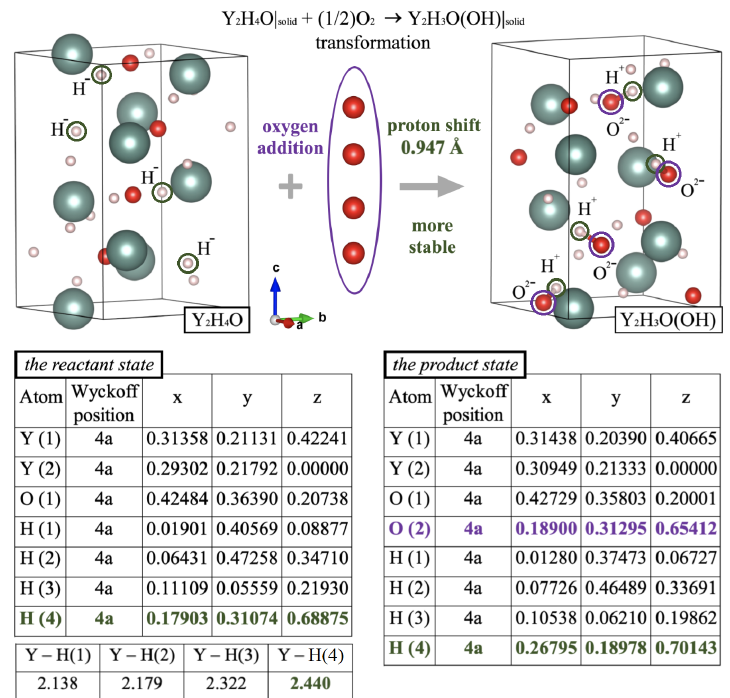
Figure 1. A schematic view of the rearrangement effect rendered as a comparison of unit cells related to less stable and more stable compositions. The color codes of atoms: Y—green, H—pink, and O—red spheres. Models of crystal packing are shown in terms positional characteristics. The H(4) and O(2) orbits which are active in the hydrogen migration are highlighted in green and in purple, respectively. Also, the “lost” hydridic hydrogens of the H(4) orbit (the left cell) converted to protons (the right cell) are ringed in green, while the added oxygens comprising the O(2) orbit are ringed in